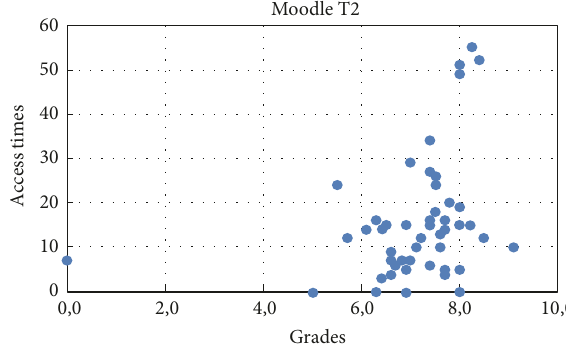
Figure 1: Scatter plot showing the amount of hits in relation to the marks obtained in the first test. It may be noticed that the more accessible the digital teaching platform, the greater the marks obtained by the students.